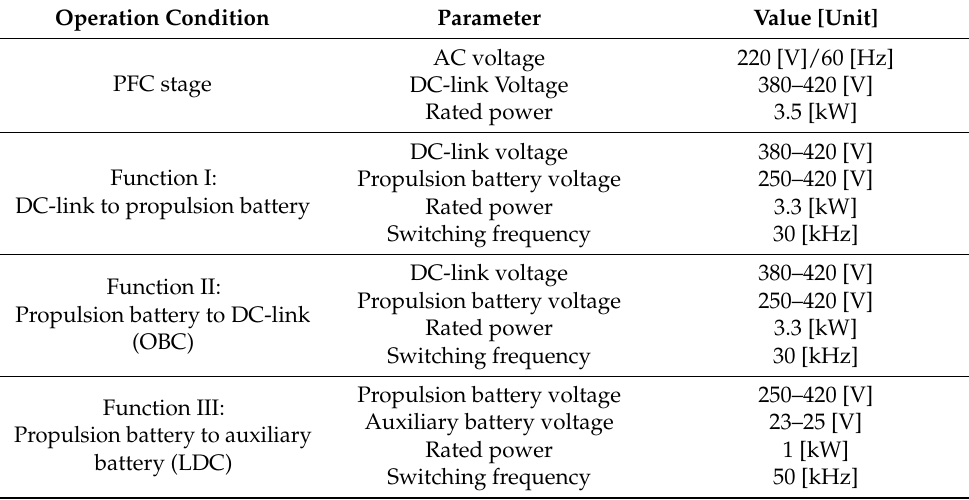
Table 1. Specification for the integrated OBC converter.